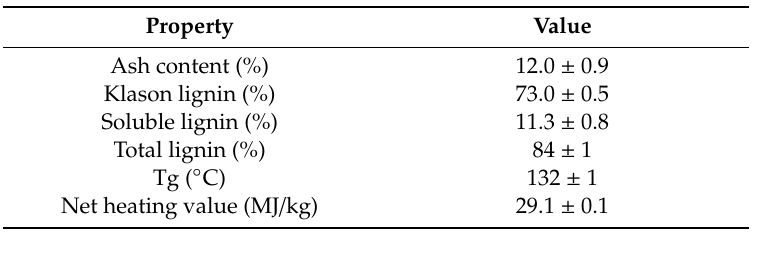
Table 1. Physical properties of lignin used in this work.